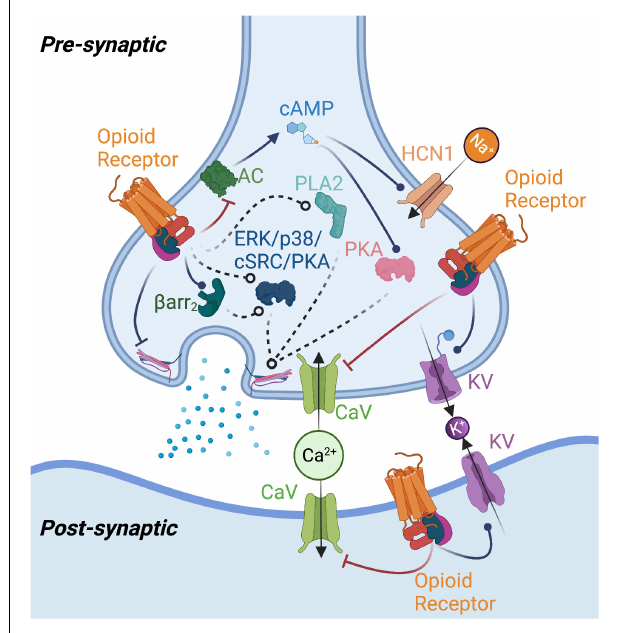
FIGURE 1 | Summary of potential mechanisms of opioid receptor-mediated modulation of neurotransmission. Opioid receptor activation enhances potassium channel (KV) and inhibits calcium channel (CaV) function, reducing neurotransmitter release or producing changes in postsynaptic excitability. Opioid receptors may modulate adenylyl cyclase (AC) function to reduce cAMP levels, thereby impacting protein kinase A (PKA) and type 1 hyperpolarization-activated cyclic nucleotide-gated (HCN1) channel activity. Beta-arrestin2 (Barr2), phospholipase A2 (PLA2), as well as kinases such as p38, ERK, protein kinase C (PKC), and cSrc have been implicated in mediating opioid receptor effects on neurotransmission. Opioid receptor-mediated G protein signaling could also directly affect neurotransmitter release machinery. Figure created with